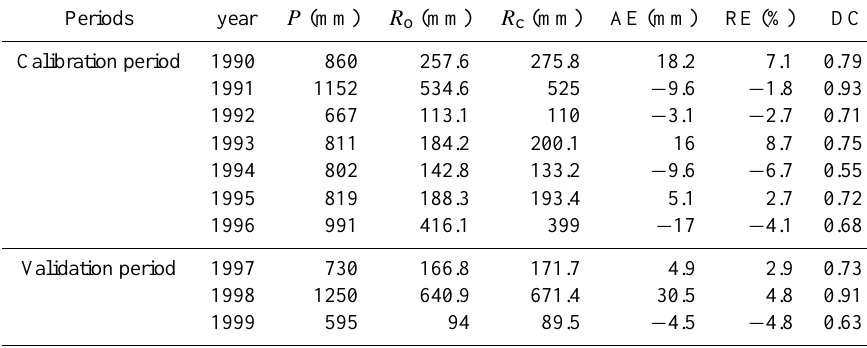
Table 2. Statistics of daily calibrated and validated results for Dapoling sub-basin in 1990s.